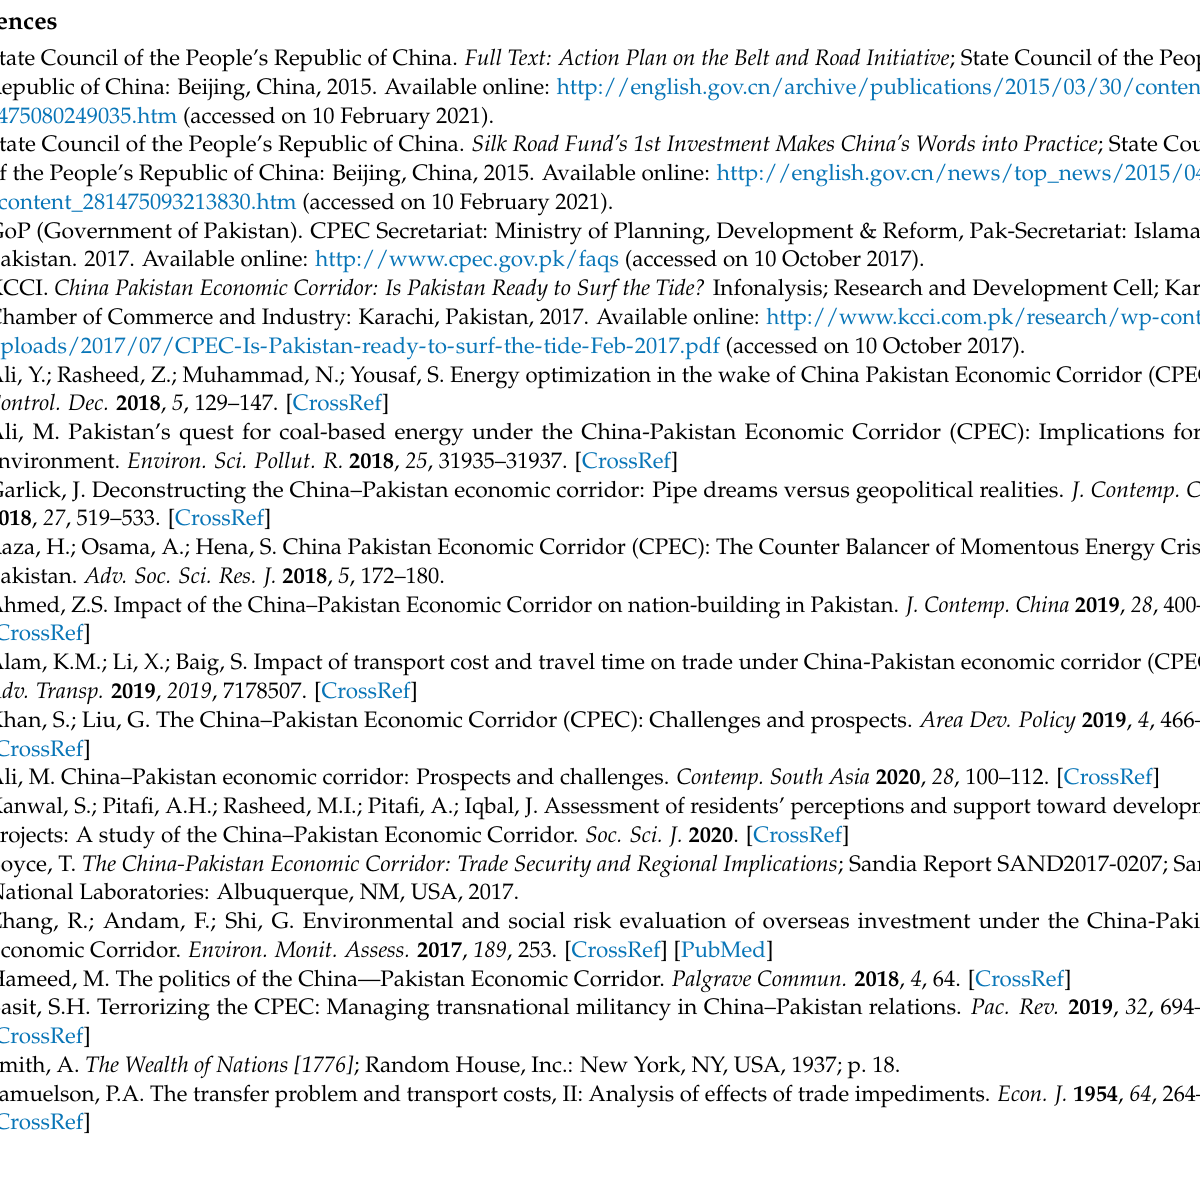
Figure A3. Outline of GTAP model. Source: Based on [91].